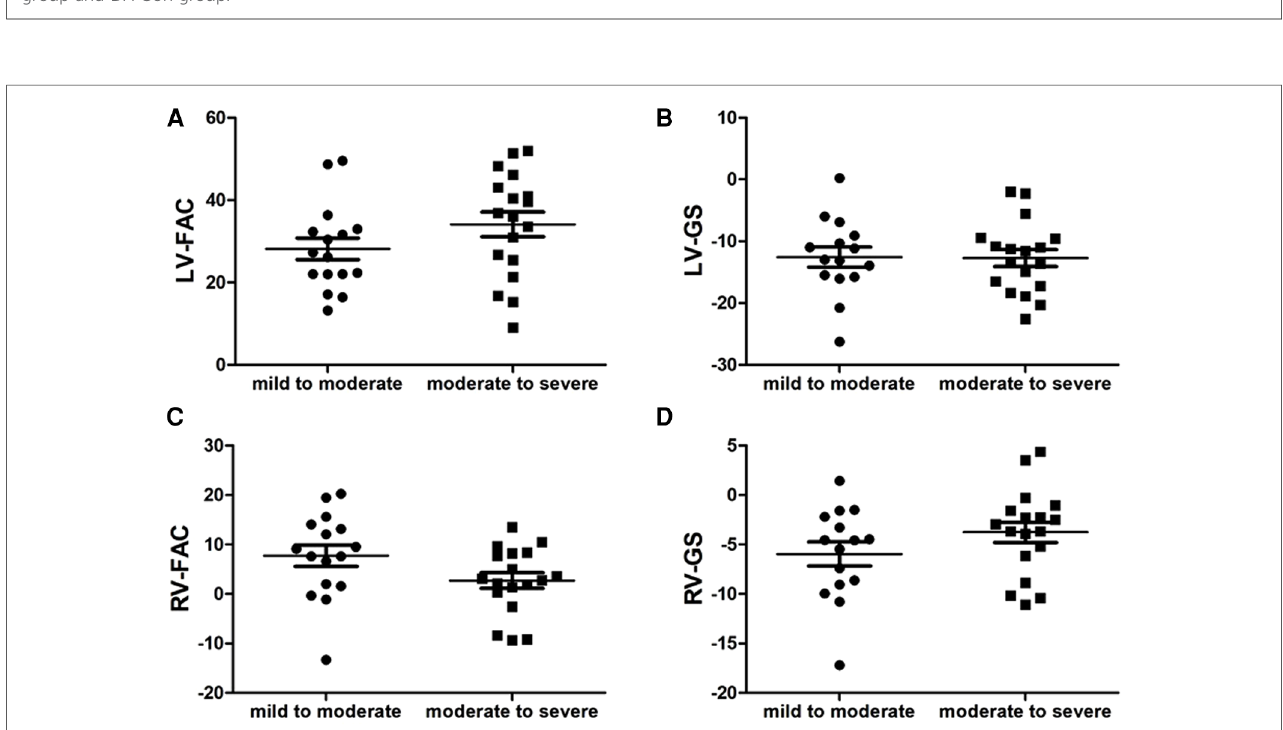
FIGURE 8 Scatter plot of left ventricle (LV)-fractional area change (FAC), LV-global longitudinal strain (GS), right ventricle (RV)-FAC and RV-GS in the fetuses with mild to moderate and moderate to severe ductus arteriosus constriction (DA Con). ( A ) LV-FAC values in the mild to moderate group and moderate to severe group. ( B ) LV-GS values in the mild to moderate group and moderate to severe group. ( C ) RV-FAC values in the mild to moderate group and moderate to severe group. ( D ) RV-GS values in the mild to moderate group and moderate to severe